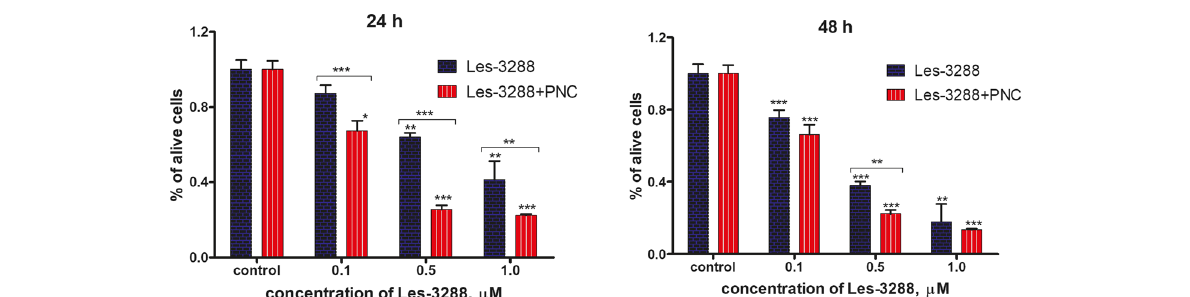
Fig. 5 Number of living rat glioma C6 cells measured by Trypan blue exclusion test after treatment for 24 h and 48 h with different concentrations (0.1, 0.5, and 1.0 μ M) of Les-3288 alone compared with the action of its complex with the polymeric nanocarrier (PNC) *P < 0.05; **P < 0.01; ***P < 0.001 ( difference in comparison to the control, 100%)